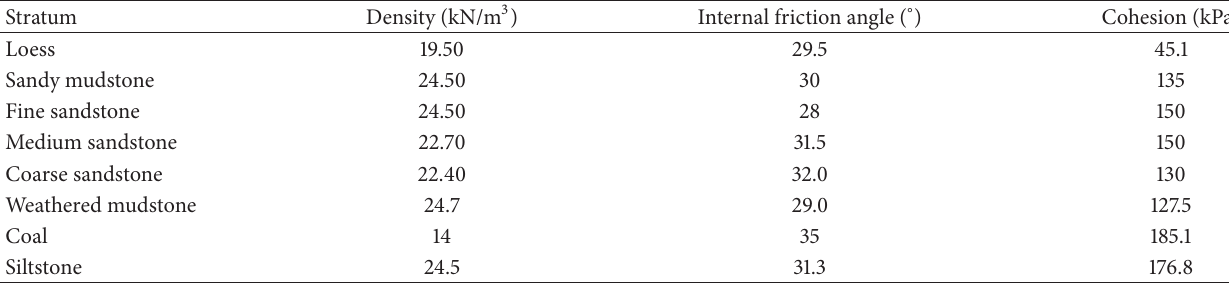
Table 4: Mechanical parameters of rock mass of Heidaigou open cast.